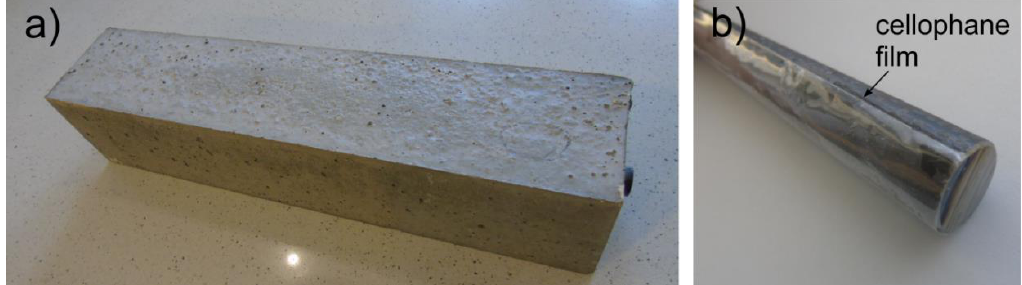
Figure 7. Experimental investigations: ( a ) Exemplary beam model, ( b ) rod covered with cellophane film before casting into concrete.